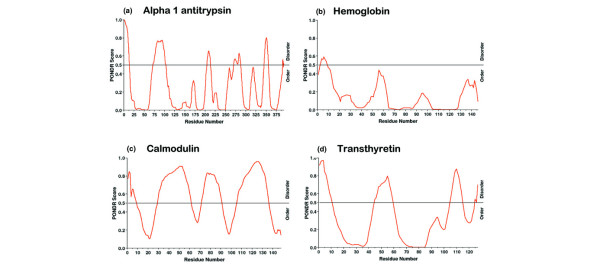
PONDR® predictions of disorder for four familiar human proteins. The SwissProt Accession Numbers [63] are given in parentheses. (a) Alpha-1-antitrypsin (P01009); (b) hemoglobin B (P02023); (c) calmodulin (P62158); (d) transthyretin precursor human (P02766). The line at PONDR® score 0.5 defines the disorder threshold and is an arbitrary measure used to distinguish order from disorder. The PONDR® predictor used here and in all other diagrams in this paper is VL-XT, which is the default predictor on the PONDR® web site.